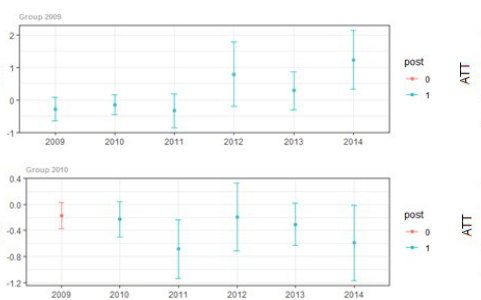
Figure 3. Group-time ATTs estimates (basic mod- el) – Mela Val di Non PDO sample.